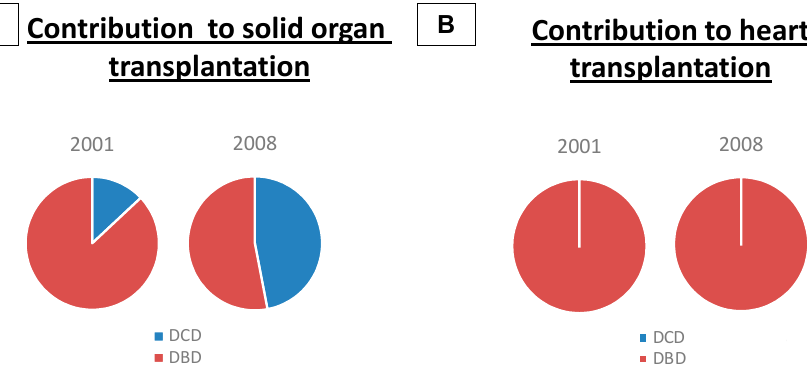
Figure 1. Contribution to solid organ transplantation divided per donor type. ( A ) The graph represents the relative percentage of organs derived from death donors in the years 2001 and 2008; ( B ) The source of hearts utilized in heart transplantation has not changed for the past two decades, deriving entirely from DBD. Abbreviations: DBD = donor after brain death; DCD = donor after cardiac death. Modified from [11].